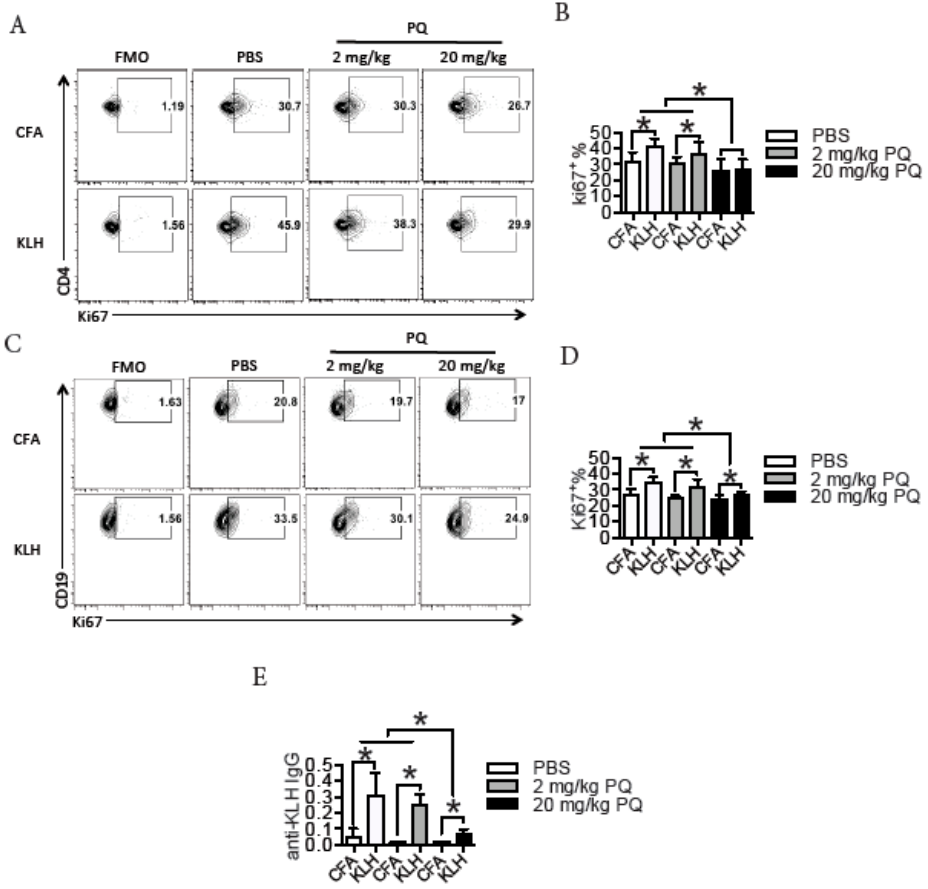
Figure 2. PQ impaired memory immune response to keyhole limpet hemocyanin (KLH). B6 mice treated with PQ for 2 wks were immunized with KLH or vehicle control at day 4 post the initial PQ treatment. After 3 months, splenic cells were harvested from portions of mice to culture with KLH in vitro (25 µ g / mL) or CFA for 2 days and thereafter proliferative CD4 T cells and B cells were measured ( A – D ); portions of mice were challenged with the 2nd KLH treatment or CFA and sera were harvested for anti-KLH IgG detection at day 3 post the 2nd KLH treatment ( E ). ( A ) Representative flow plots for splenic CD4 T cell proliferation (Ki67 + ) after stimulation with KLH in vitro; CD4 T cells were gated on CD3 + CD4 + cells. ( B ) Quantification of proliferative CD4 T cells as indicated in B. ( C ) Representative flow plots for splenic B cell proliferation (Ki67 + ) after stimulation with KLH in vitro; B cells were gated on CD19 + cells. ( D ) Quantification of proliferative B cells as indicated in C. ( E ) Serum anti-KLH IgG in PQ-treated mice after the 2nd KLH stimulation. A total of 6 to 8 mice were used for each group. Asterisk represents a significant difference as indicated.